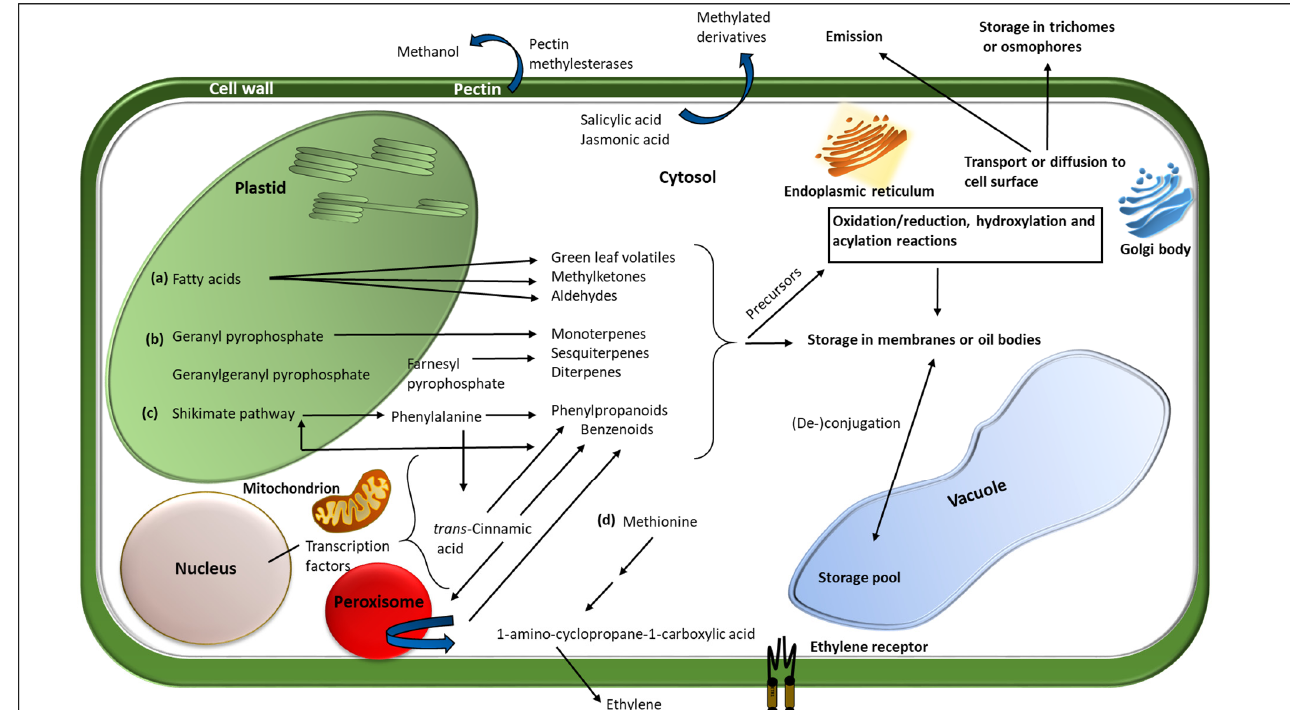
Figure 1. Biosynthetic sites, storage, and transport of major plant volatile organic compounds. The four major biosynthetic classes, ( a ) fatty acids, ( b ) terpenoids, ( c ) benzenoids, and ( d ) amino acids, are represented in the figure. Modification reactions including redox reactions, hydroxylation, acylation, and degradative reactions occur mainly in the cell cytosol. Some reactions may also occur in the membrane-bound sub-cellular compartments such as plastids, mitochondria, and endoplasmic reticulum. Inactive forms of the VOCs such as glycosides are stored in the vacuole, ducts, and other extracellular compartments such as trichomes. Transport of the volatiles is by passive diffusion and possibly via vesicular trafficking by the endoplasmic reticulum, golgi apparatus, and the trans -golgi network. (Modified from Pichersky et al. [51]).